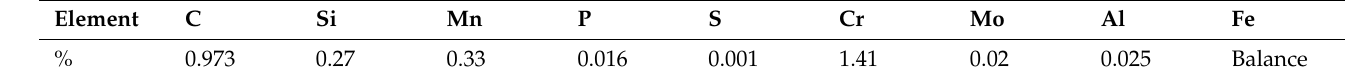
Table 3. The chemical composition of AISI 52100 bearing steel.